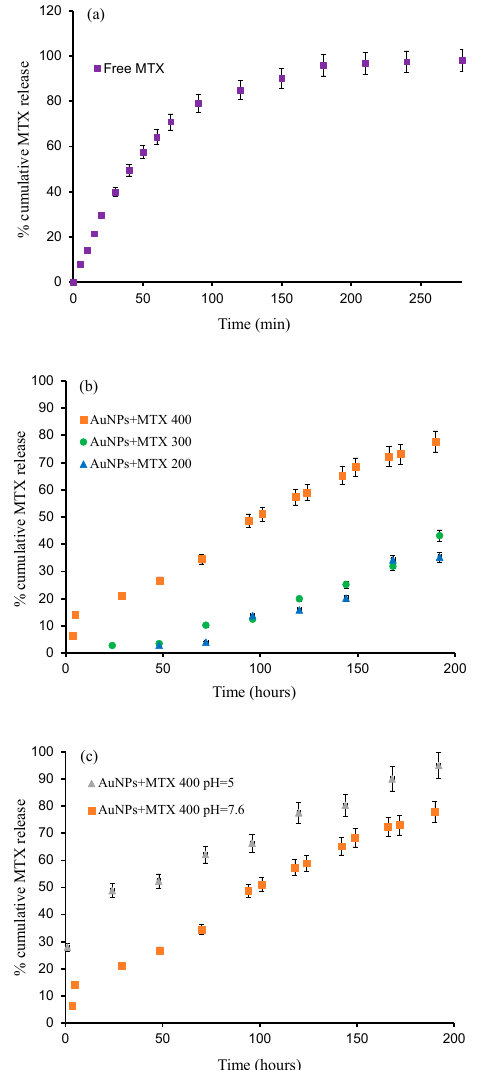
Figure 7. The release profiles of: ( a ) Free MTX; ( b ) AuNP–MTX 400, AuNP–MTX 300 and AuNP–MTX 200; ( c ) AuNP–MTX 400 at pH 7.6 and pH 5.